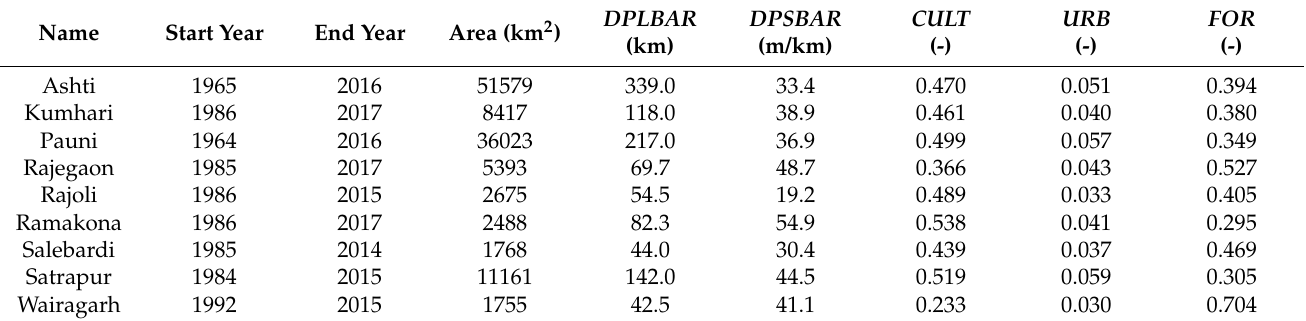
Table 1. Sub-catchments of the Wainganga considered in this